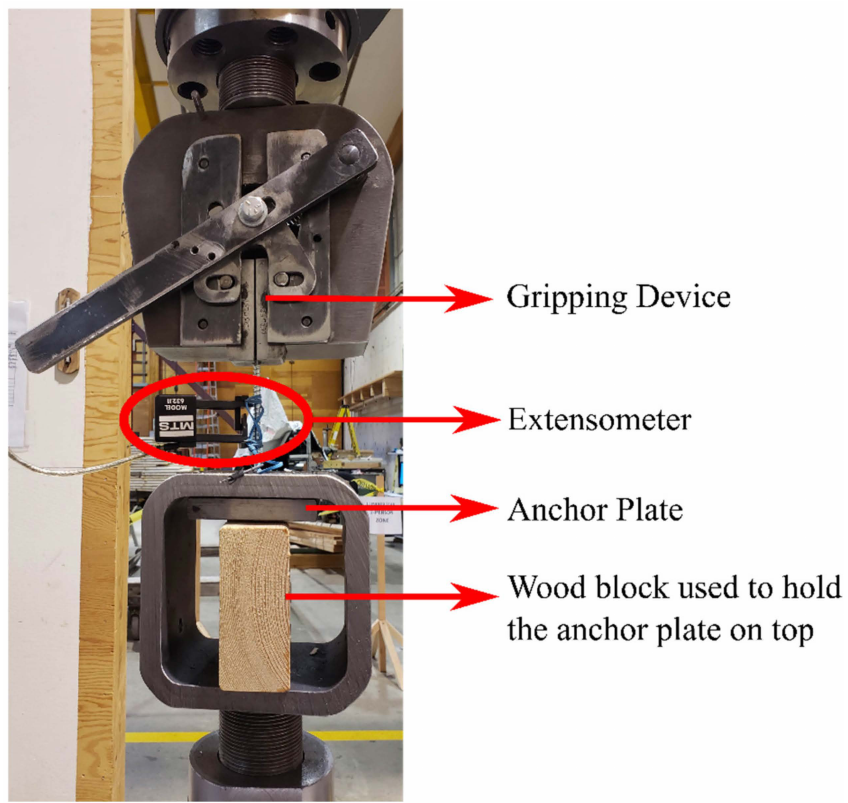
Figure 2. Complete screw tensile test